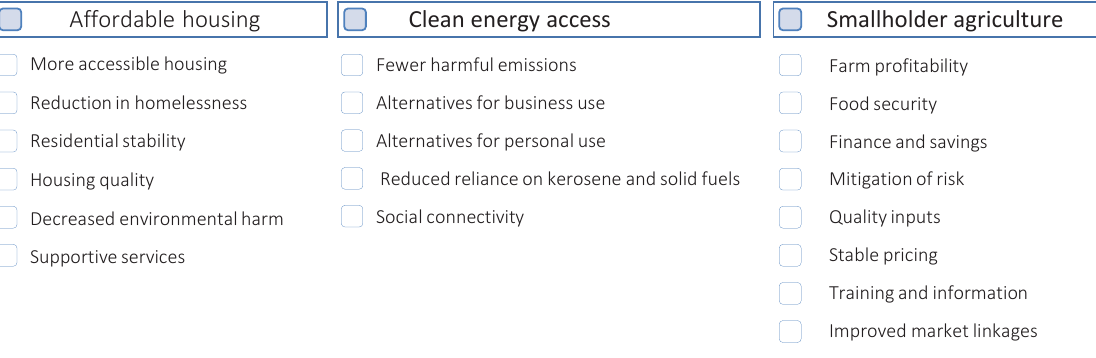
Figure 2. Perspective areas of impact investing in